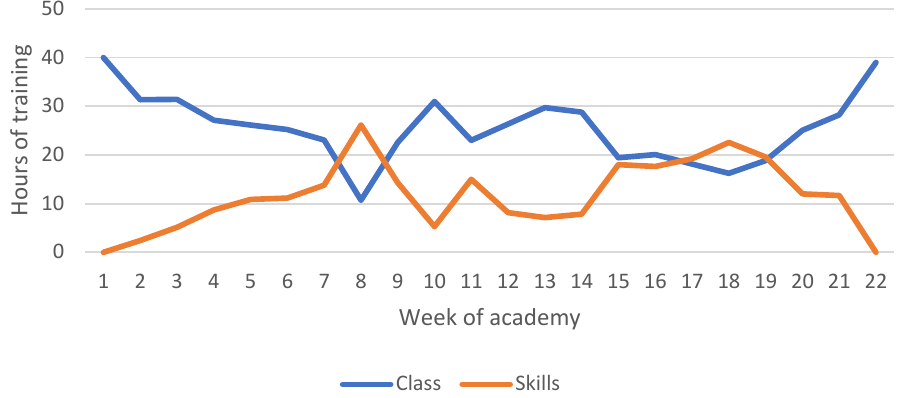
Figure 6. Average hours of class and skill training per week across seven academy classes.